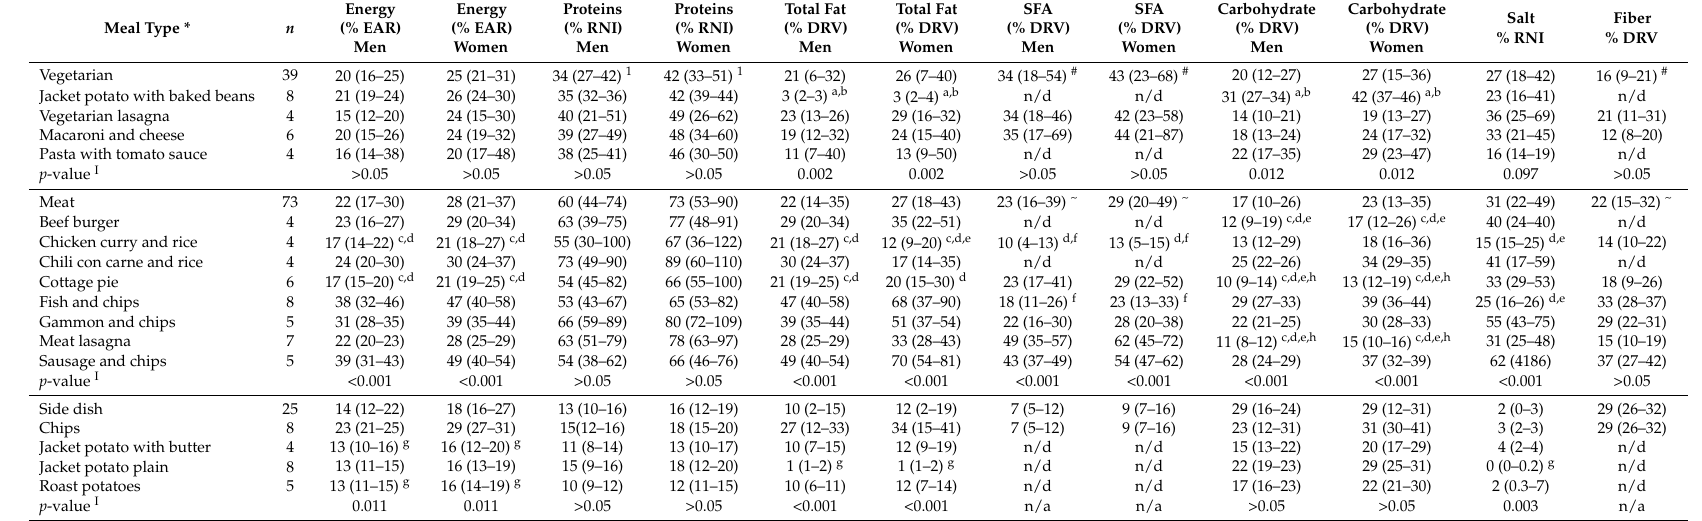
Table 4. Energy and macronutrients profile of the meals as percentage of UK daily reference values for healthy adults (19–50 years